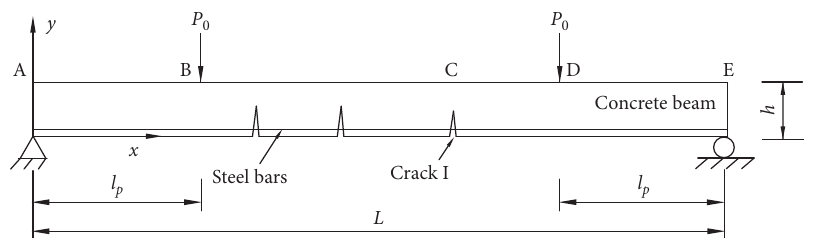
Figure 1: A reinforced concrete beam with cracks.